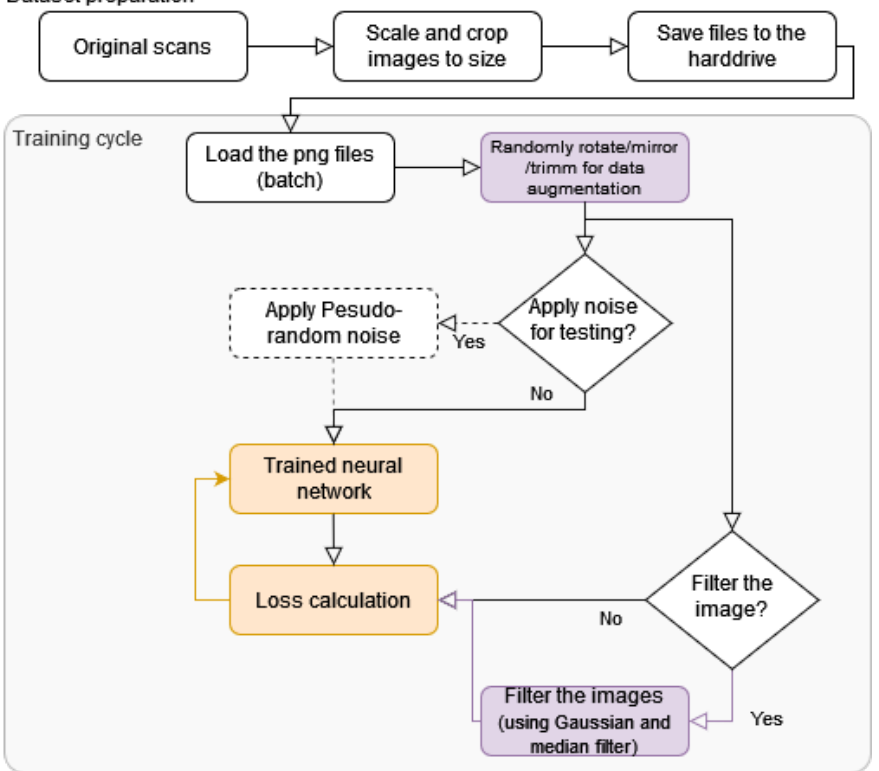
Figure 6. Graph presenting the used pipeline for autoencoders training and testing. Orange color represents training with the backpropagation, purple presents the described